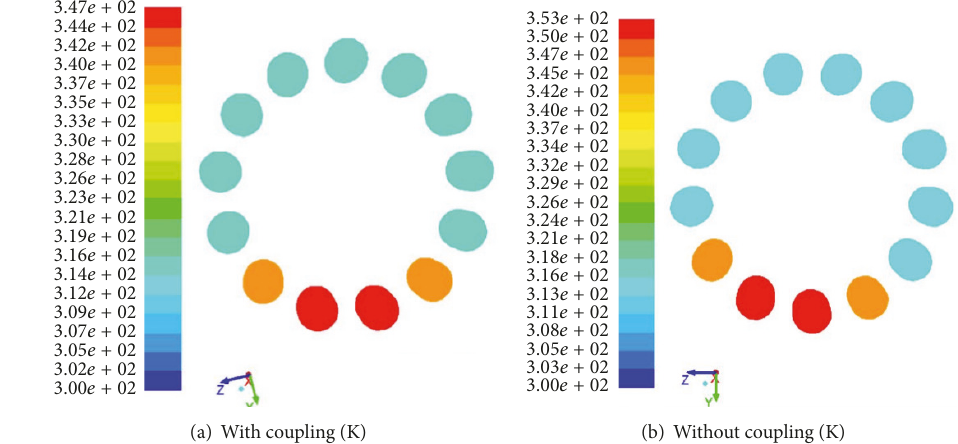
Figure 8: Temperature of the end face of rollers.